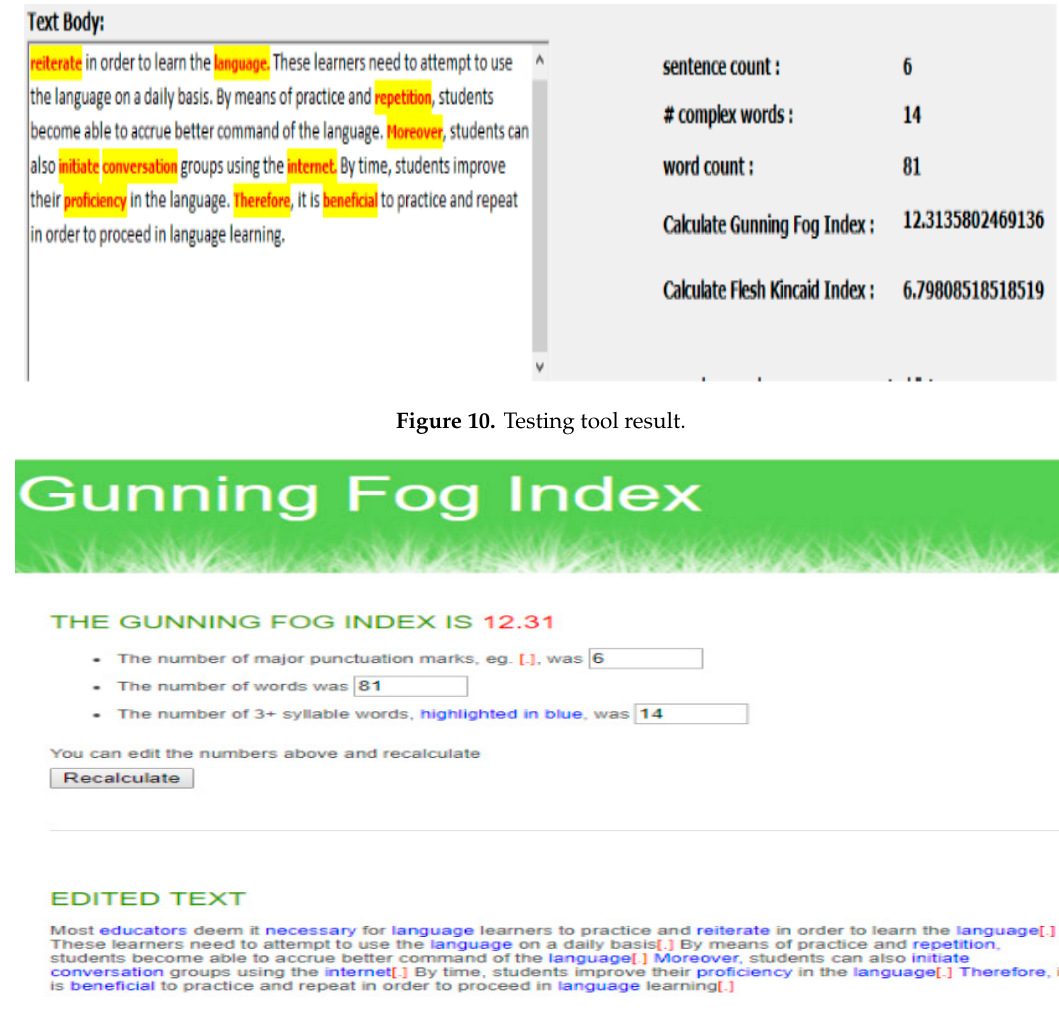
Figure 11. Testing from another resource: http://gunning-fog-index.com/fog.cgi.